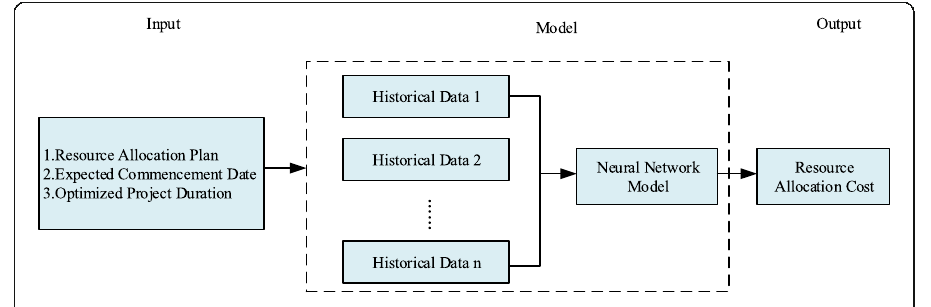
Fig. 1 Resource optimization